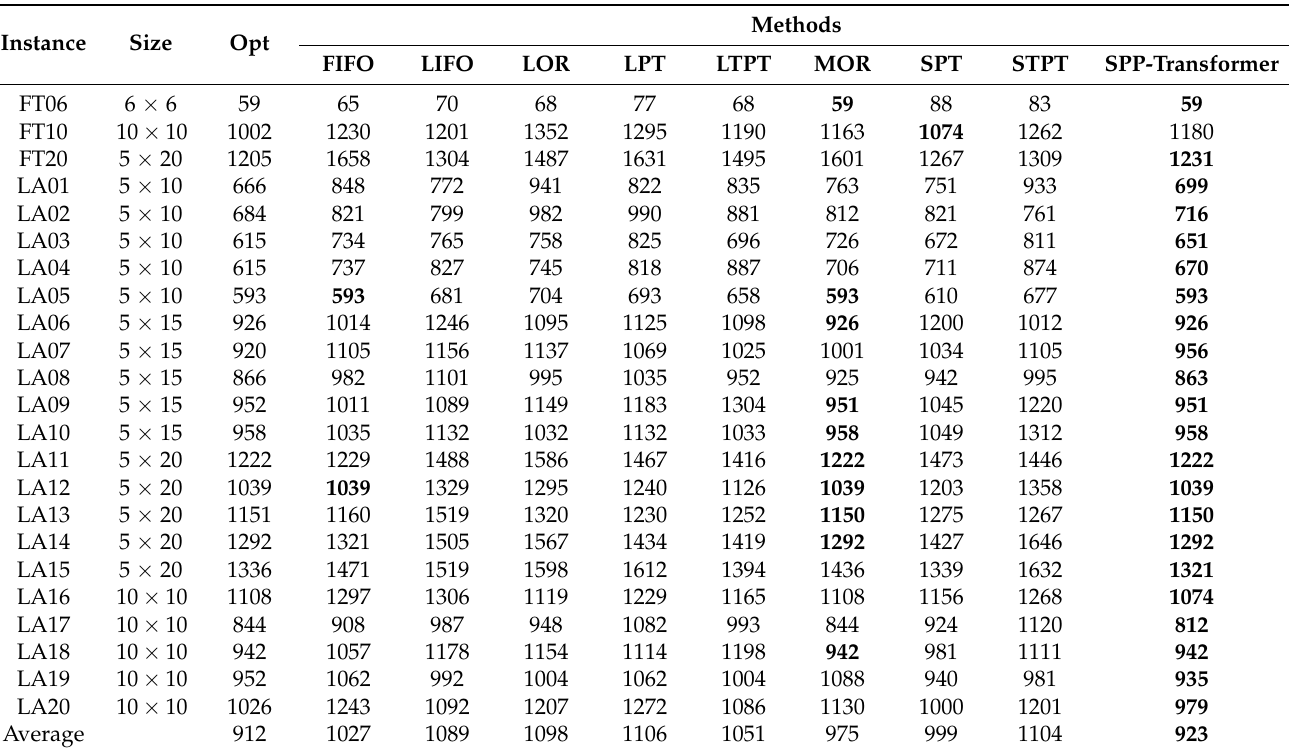
Table A1. The comparison between simple priority rules and SPP-Transformer on makespan.